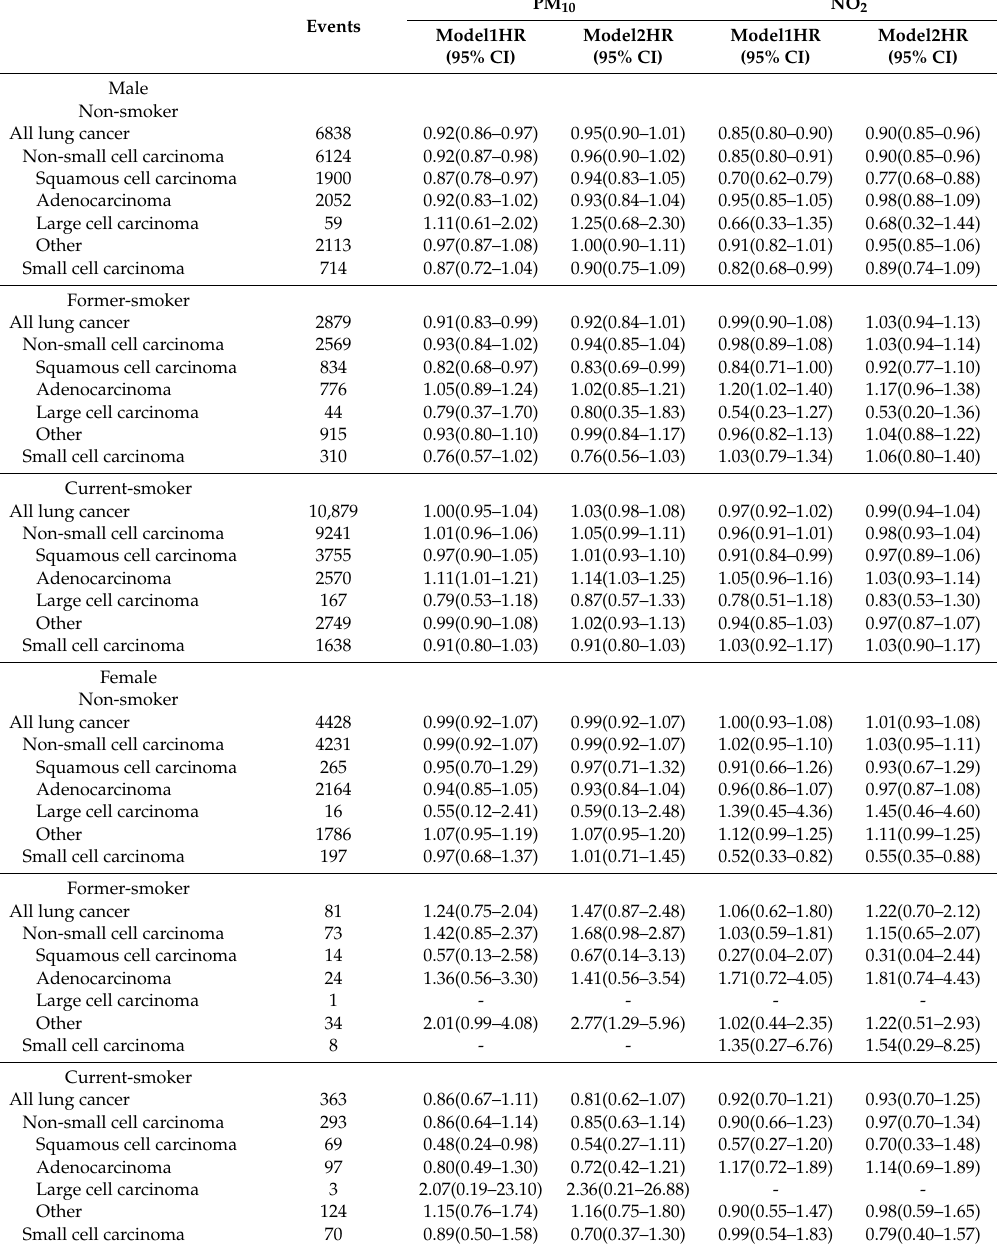
Table 5. Risk of lung cancer incidence by histological classification according to exposure to PM 10 or NO 2 by gender and smoking